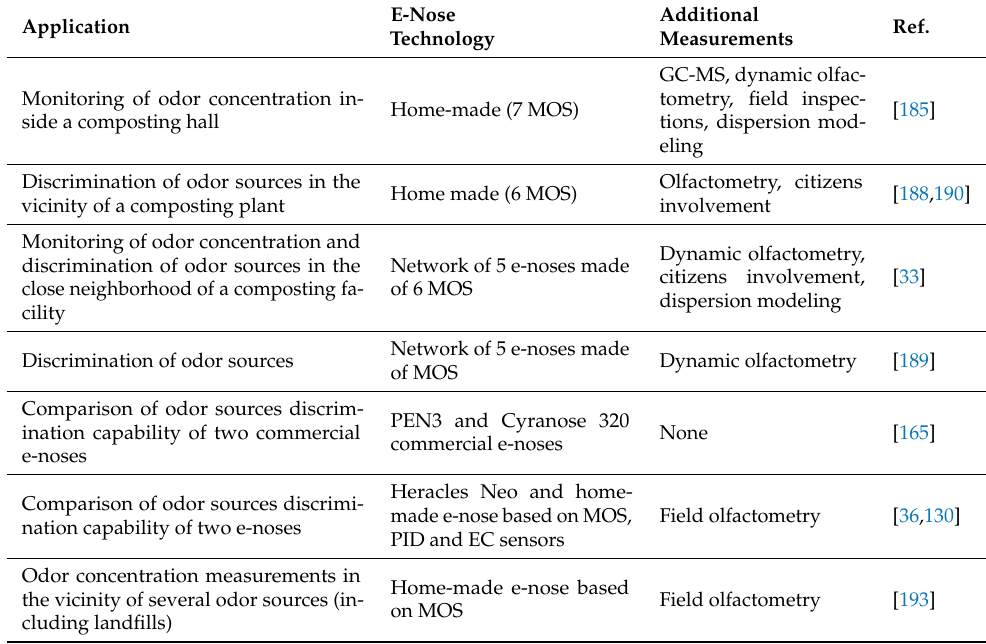
Table 8. Examples of sensorial e-noses applications in the waste management